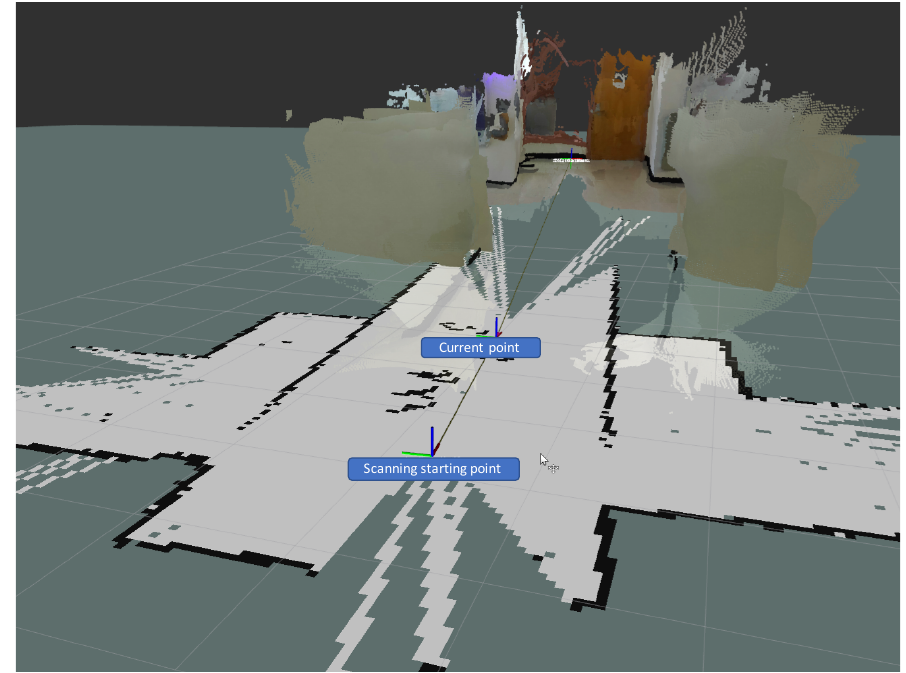
Figure 17. The sensor fusion result of the 2D and 3D mapping.